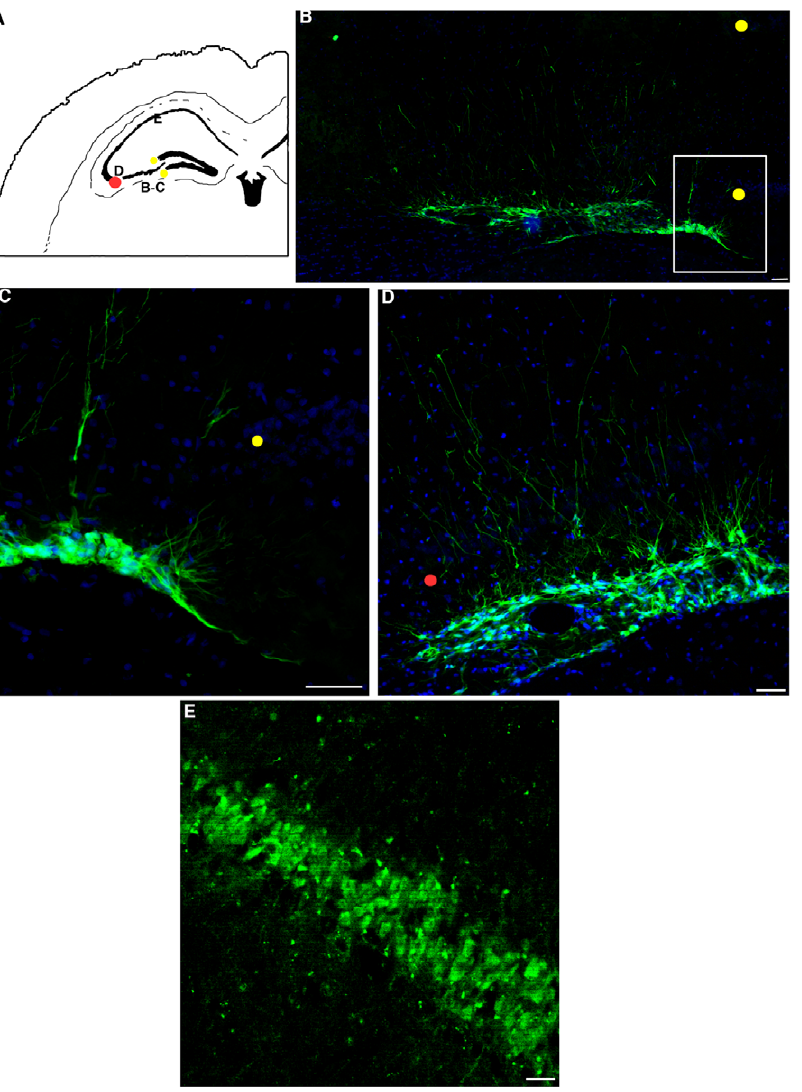
Figure 5. At four months after transplant IhNSC-Ps integrate in the hippocampal layers under transient immunosuppression. (A) Schematic map of the hyppocampal layers colonized by IhNSC-Ps in transiently immunosuppressed ischemic rats. The letters are positioned next to the regions referred to the figures B–E. (B–D) At 4 months following transplantation IhNSC-Ps were found integrated into the CA3 layer and in the underling SVZ (B), emitting long processes toward the dentate gyrus (boxed area in B, shown at higher magnification in (C) and CA1 layer (B–D). (E) At this time IhNSC-Ps were also found distributed along the CA1 layer. Scale bars: in B–D: 50 m m, in E: 30 m m.